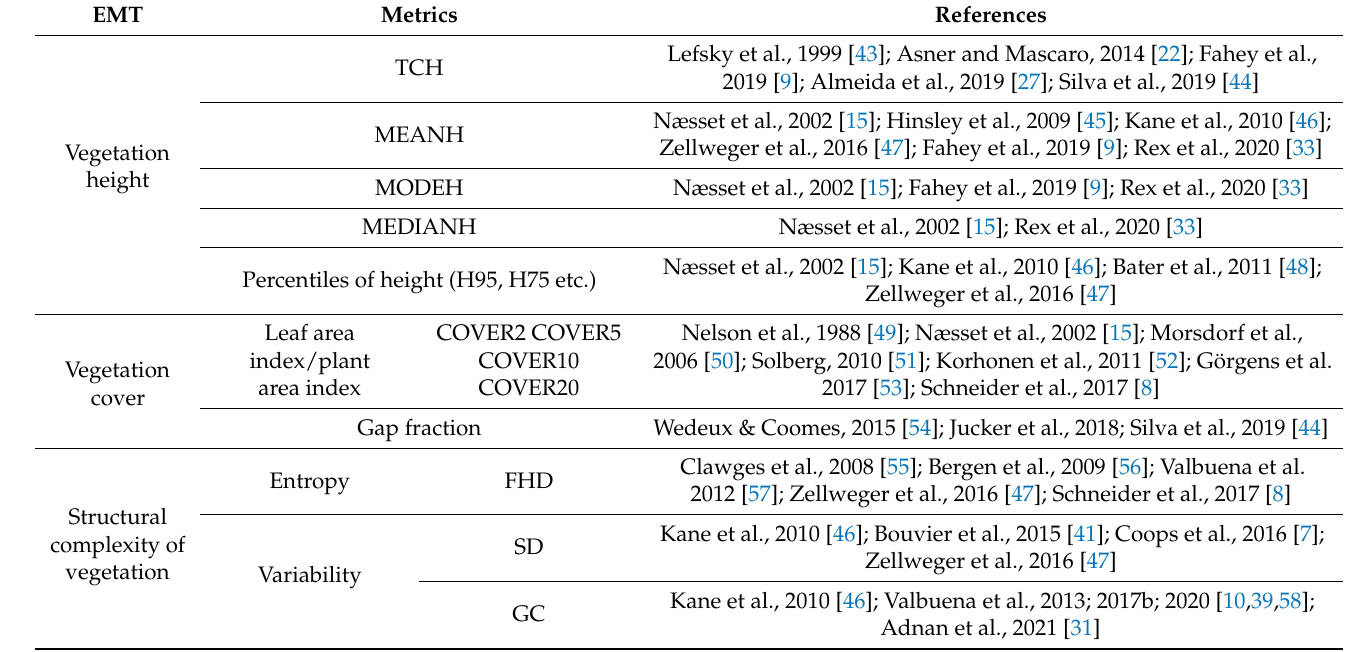
Table 1. Ecosystem morphological traits, their associated metrics, and examples of their